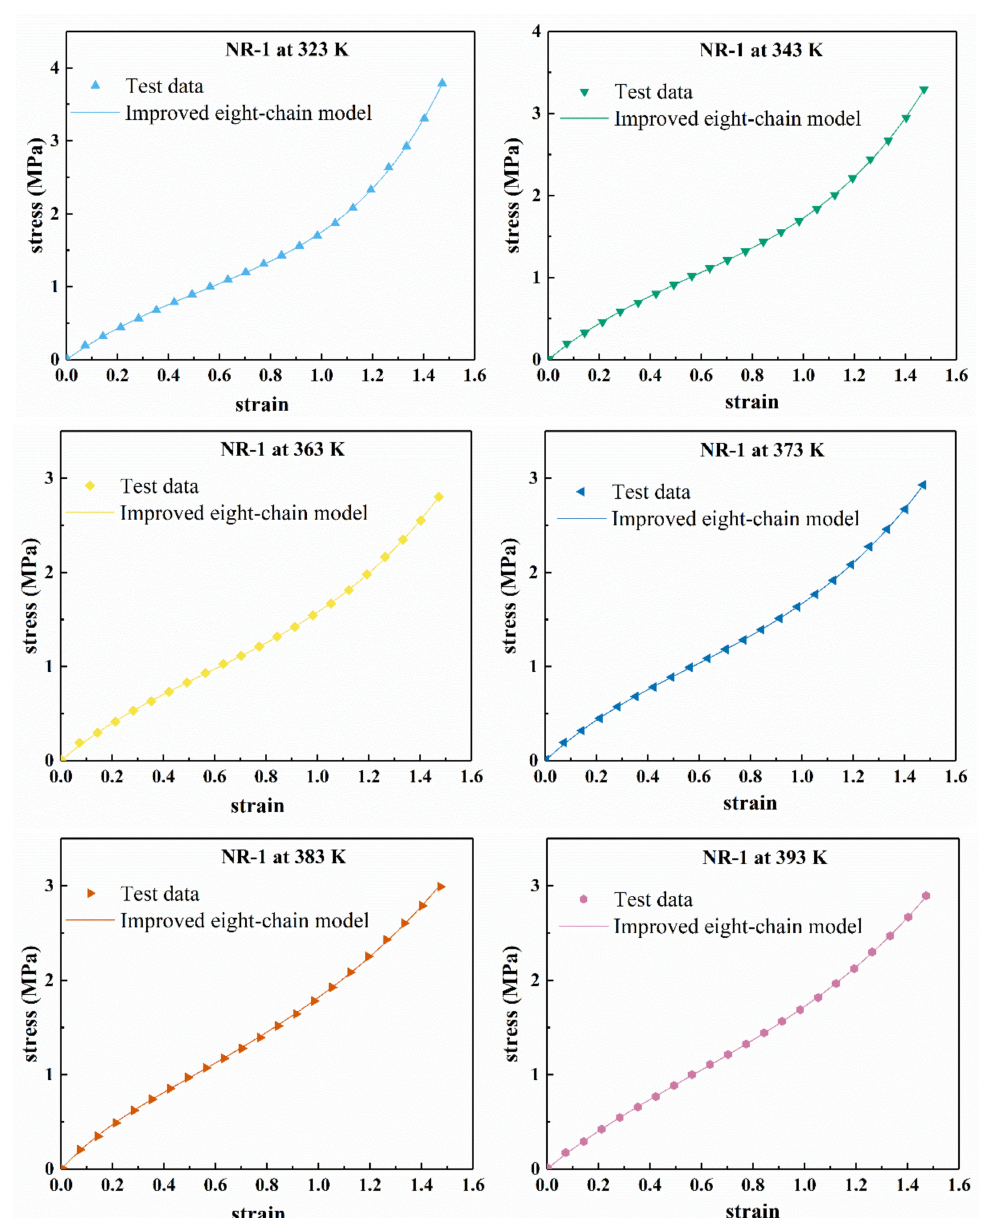
Figure 11. Fitting results of NR-1 under uniaxial tension at different temperatures by improved eight-chain model.